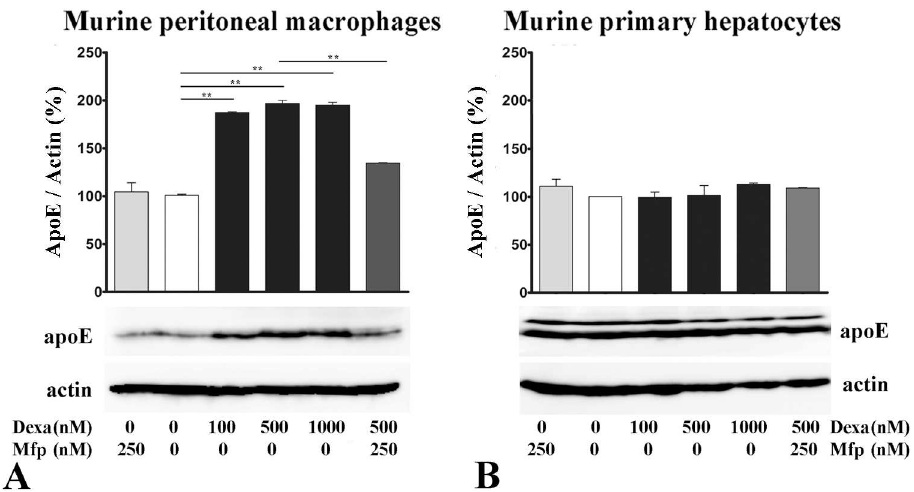
Fig 3. Macrophage-specific enhancement of apoE protein expression by dexamethasone. (A) Dexamethasone(100–1000nM, 48 hours) significantly increasesthe expressionof apoE protein in mouse peritonealmacrophages (MPM), and mifepristone attenuates this effect. (B) No alterationin apoE protein expressionis detectedin murineprimaryhepatocytes(MPH) underdexamethasonetreatment.Western blots resultswerenormalizedto β -actin.Upperpanelsrepresentthe quantificationof threeindependent experiments, andlowerpanelsare representative images. The symbol ** is for p < 0.01.